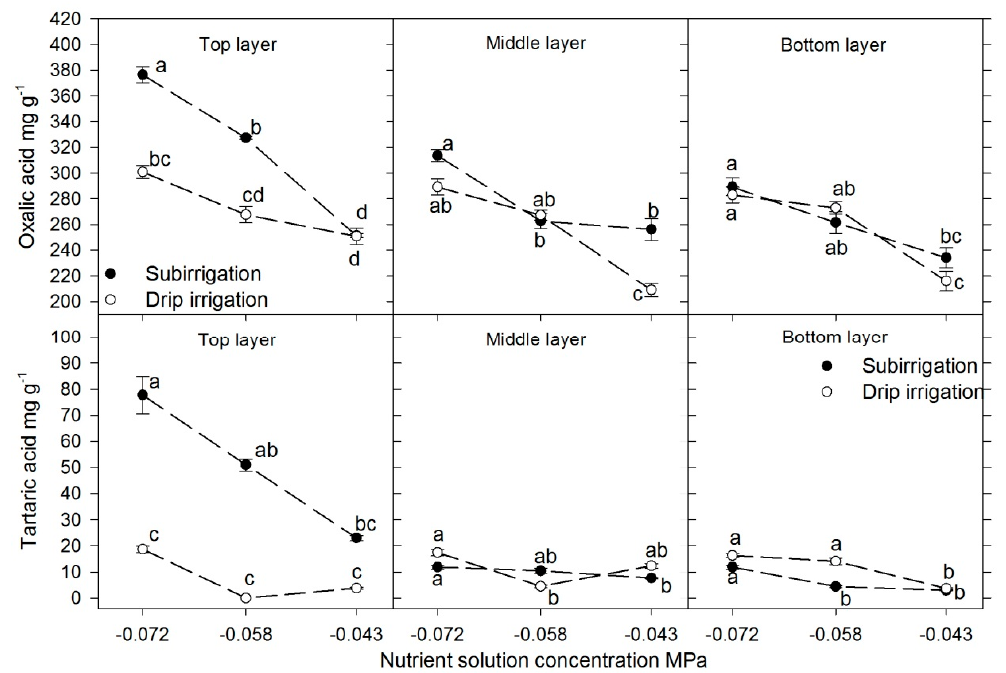
Figure 5. Substrate organic acids concentration at the termination of the experiment with tomato ( Solanum lycopersicum L.) plants, as affected by, for oxalic acid, irrigation method (IM, p ≤ 0.001), nutrient solution concentration (NSC, p ≤ 0.001), substrate layers (SL, p ≤ 0.004) and the interactions between factors (IM × NSC, p = 0.206; IM × SL, p ≤ 0.004; NSC × SL, p = 0.313; IM × NSC × SL, p ≤ 0.001), for tartaric acid, as affected by irrigation method (IM, p ≤ 0.001), nutrient solution concentration (NSC, p ≤ 0.001), substrate layers (SL, p ≤ 0.001) and the interactions between factors (IM × NSC, p ≤ 0.001; IM × SL, p ≤ 0.001; NSC × SL, p ≤ 0.001; IM × NSC × SL, p ≤ 0.001). Means with the same small case indicate non-significant differences according to Tukey´s multiple comparison test. Bars represent the standard error of the mean (n = 4).